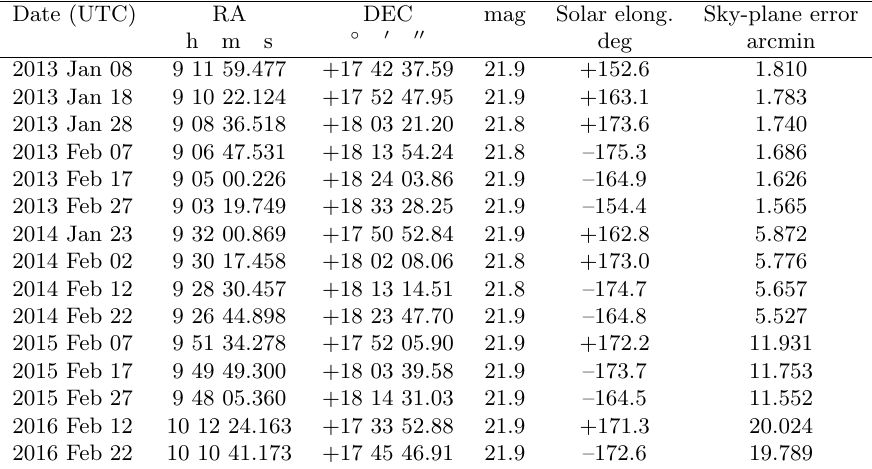
Table 5. Ephemerides of the asteroid 2012 DS85 for its visibility in 2013– 2016. The coordinates (J2000) for a geocentric observer are given. Date (UTC)